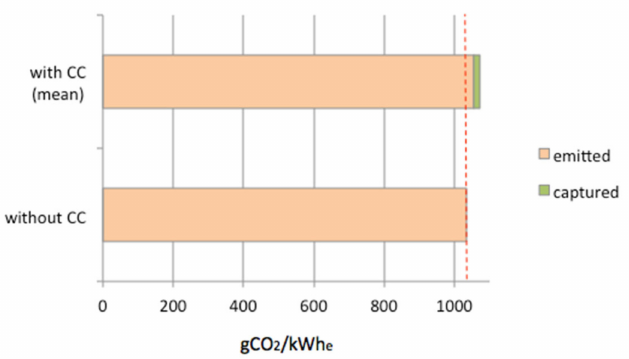
Figure 4. CO 2 emitted by the coal-fired power